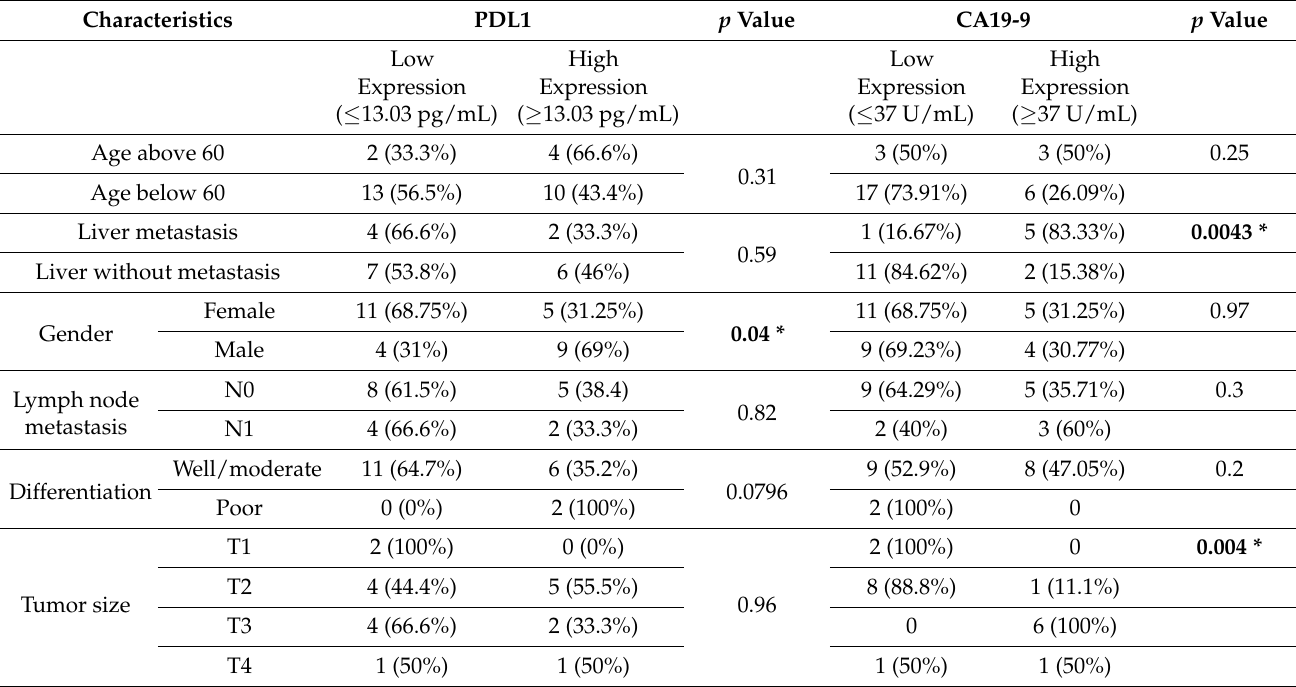
Table 1. Patients’ clinico-pathological characteristics correlated with PDL1 and CA19-9 concentration at their respective optimum cut-off values (13 pg/mL and 37 U/mL), ( n =